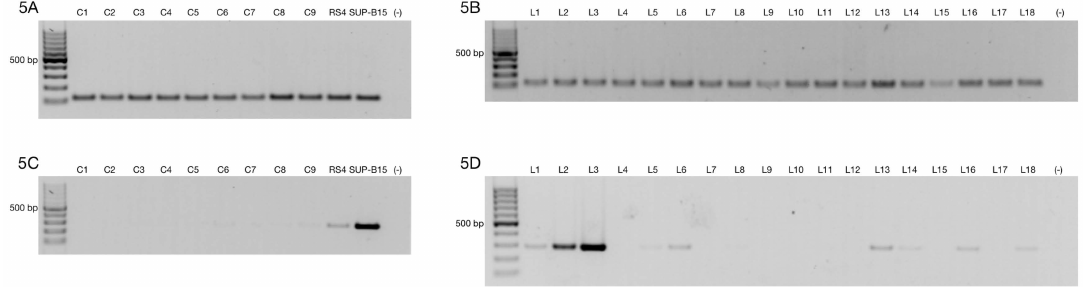
Figure 5. Comparison of ZNF695_TV1 expression in healthy subjects and B-ALL patients. ( A ) The RPL4 housekeeping gene was expressed in nine healthy donors and two positive controls (the RS4 and SUP-B15 cell lines). Agarose gel evaluating cDNA integrity via expression of the housekeeping gene. ( B ) Representative gel of the 43 B-ALL patients analyzed. The RPL4 housekeeping gene was expressed in all samples. ( C ) The agarose gel showed very low expression of ZNF695_TV1 in the healthy controls. ( D ) Agarose gel showing ZNF695_TV1 expression in B-ALL